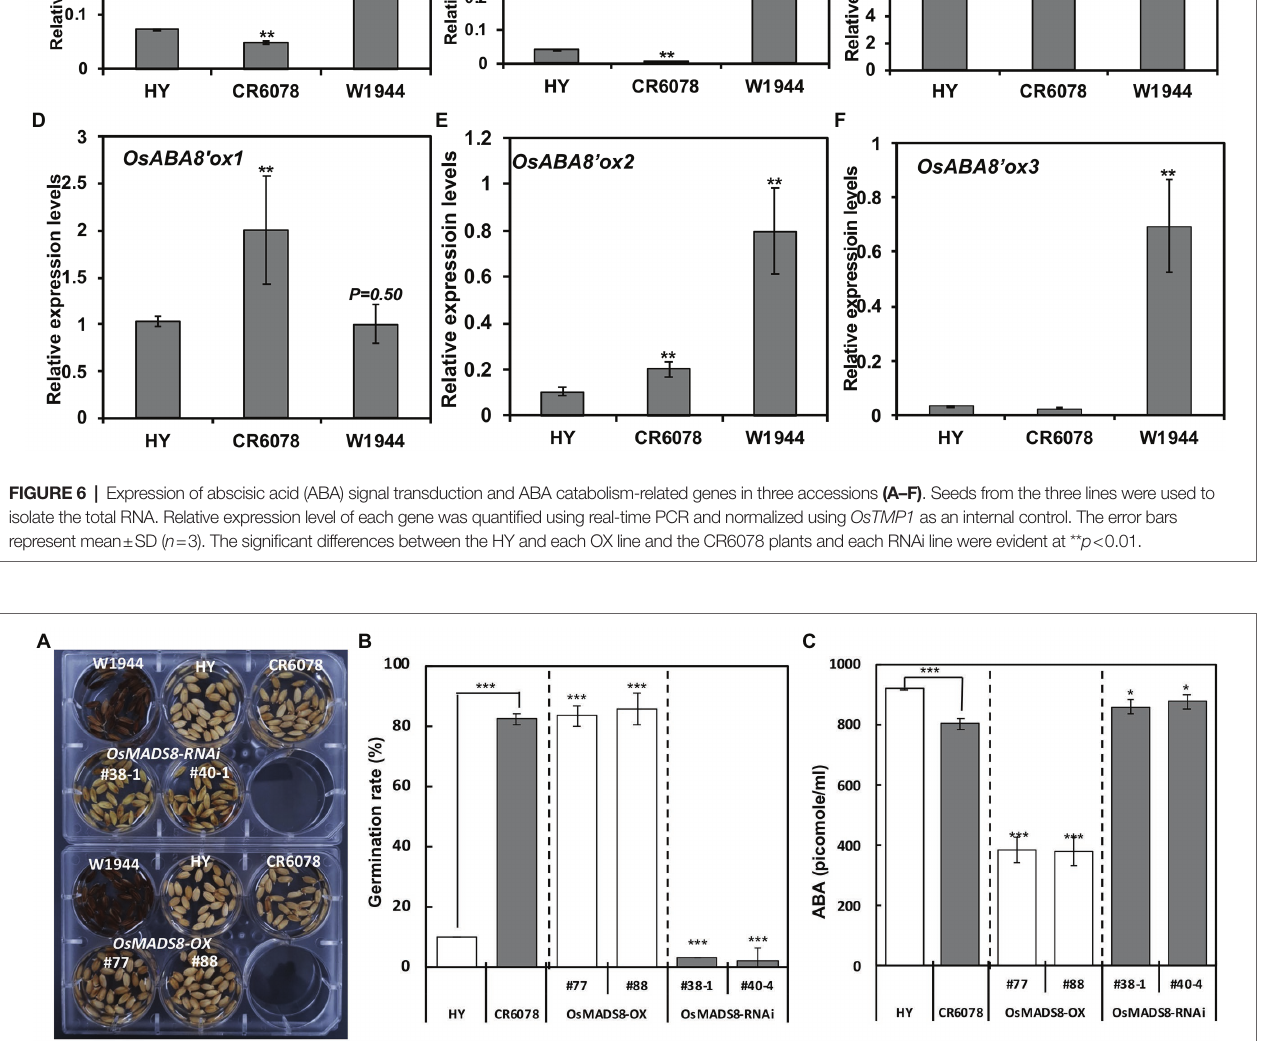
FIGURE 7 | Comparison of germination ratio at 30 ° C and ABA contents in the transgenic and control plants. (A) The CR6078 and OsMADS8 -OX lines showed a significantly higher germination ratio than the HY and OsMADS8 -RNAi at 24 h after sowing. (B) The significant differences between the HY and CR6078, the HY and each OX line, and the CR6078 plants and each RNAi line were evident at *** p < 0.001. The germination rate (based on the length of radicles >1 mm) was recorded, and values are represented as mean ± SD ( n = 3). (C) Analysis of the ABA content in the OsMADS8 transgenic lines and controls. The error bars represent mean ± SD ( n = 3). Data represent the average of three replicates. The comparison was made between the HY and CR6078, and the HY and each OX line, and the CR6078 and each RNAi line. Significant differences were evident at * p < 0.05 and *** p <